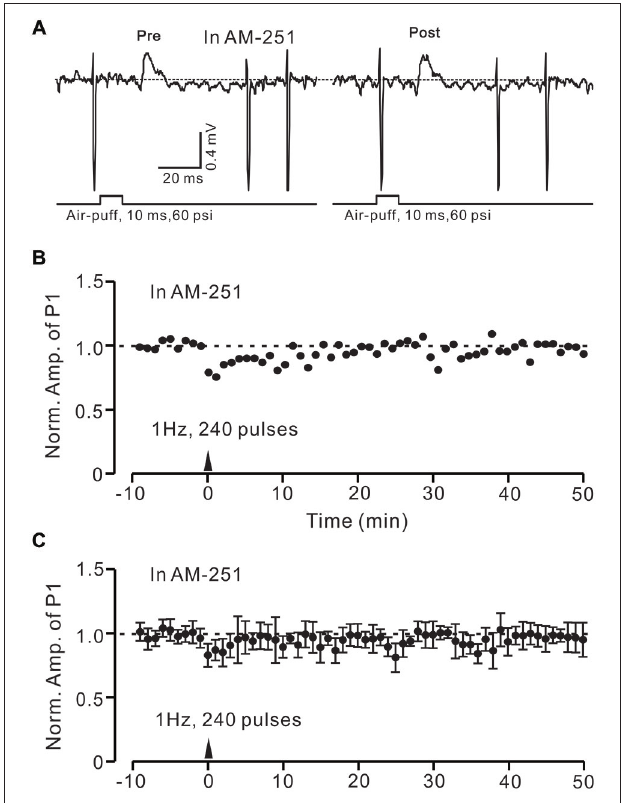
FIGURE 6 | Facial stimulation-induced LTD of GABAergic transmission at PCs was abolished by blocking cannabinoid type 1 (CB1) receptor activity . (A) Representative cell-attached recording traces showing air-puff stimulation (10 ms, 60 psi)-evoked responses in a cerebellar PC before (pre) and after (post) delivering 1 Hz (240 pulses) stimulation delivered in the presence of CB1 antagonist, AM251 (5 µ M). (B) Time course of normalized amplitude of P1 (shown in A ) before and after delivery of 1 Hz facial stimulation (arrow head) delivered in the presence of AM251. (C) Summary of normalized amplitude of P1 before and after delivery of 1 Hz (240 pulses) stimulation (arrow head; n = 7) delivered in the presence of AM251. Note that air-puff stimulation (1 Hz)-induced LTD of P1 was blocked by application of a CB1 receptor antagonist. Data points are mean ± SEM.